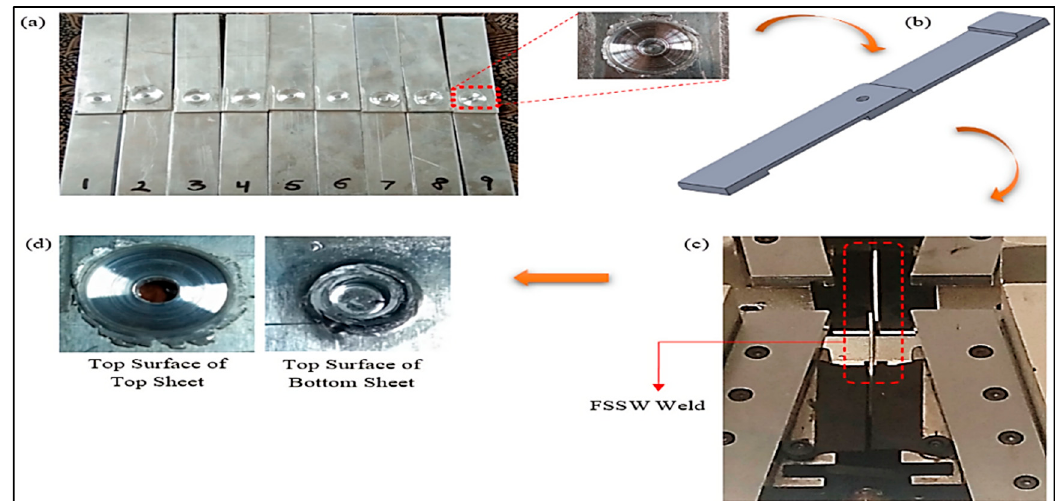
Figure 6. ( a ) 9 FSSW specimens; ( b ) FSSW test sample, ( c ) test sample secured in the UTM; ( d ) fractured sample.